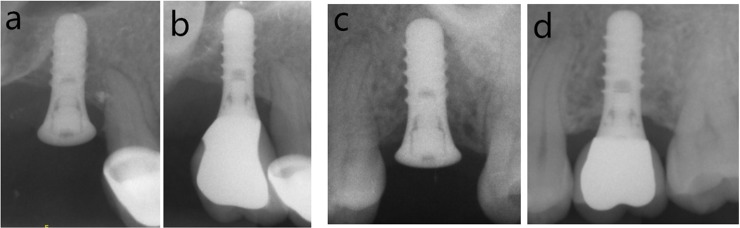
Radiographs in SG group: a) baseline, b) follow-up, and in CG group: c) baseline, d) follow-up.